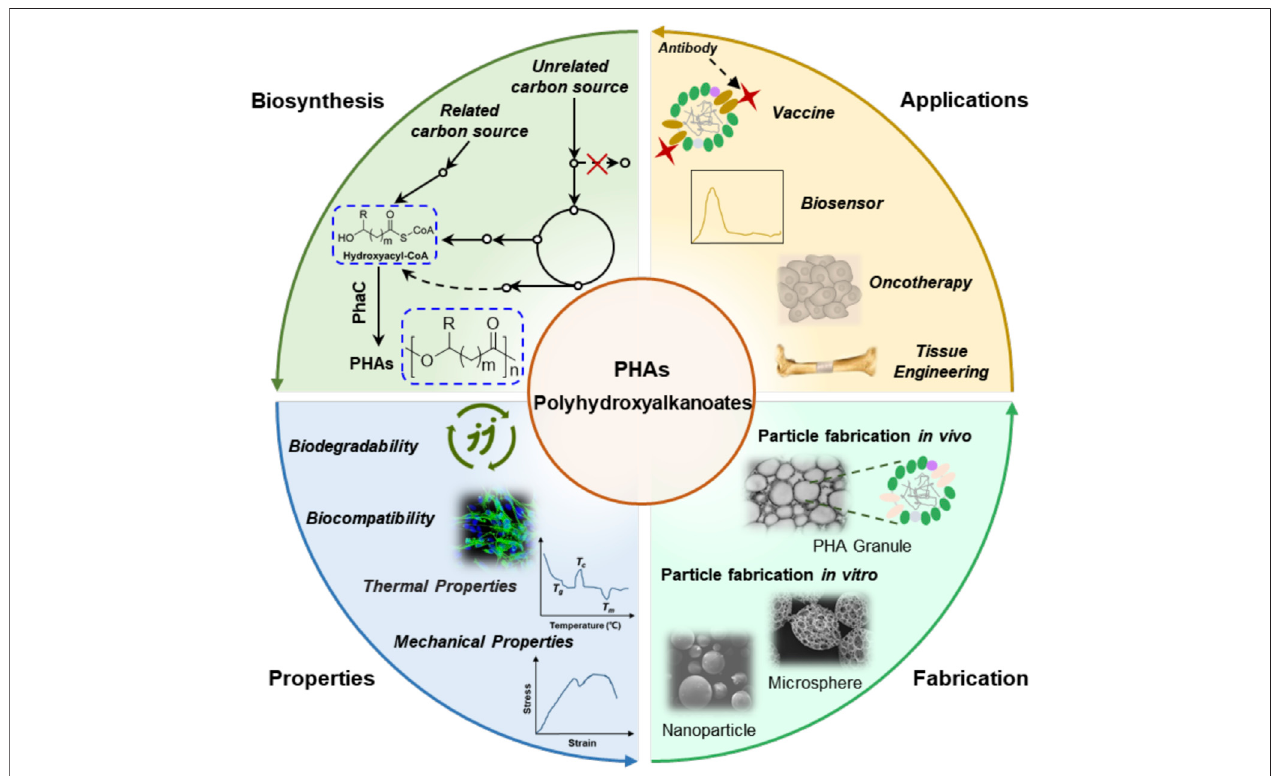
FIGURE 1 | Overview of polyhydroxyalkanoates (PHA) from biosynthesis to therapeutic applications.